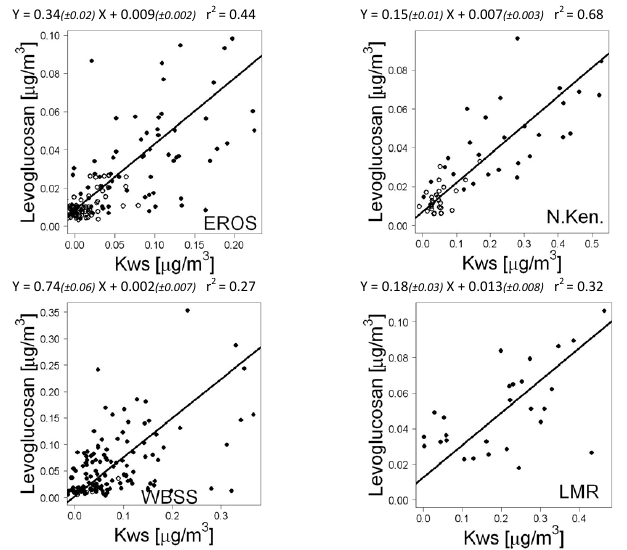
Fig. 2. Relationship between levoglucosan and K ws measured at EROS (4 May 2009–31 March 2010) (top left plot) and Budbrooke (19 November 2009–8 April 2010) (bottom left plot) and North Kensington (16 February–15 March 2011 and 3–29 June 2010) (top right plot) and Marylebone Road (16 February–15 March 2011) (bottom right plot). All are fitted using a RMA regression. Filled circles represent winter and open circles,